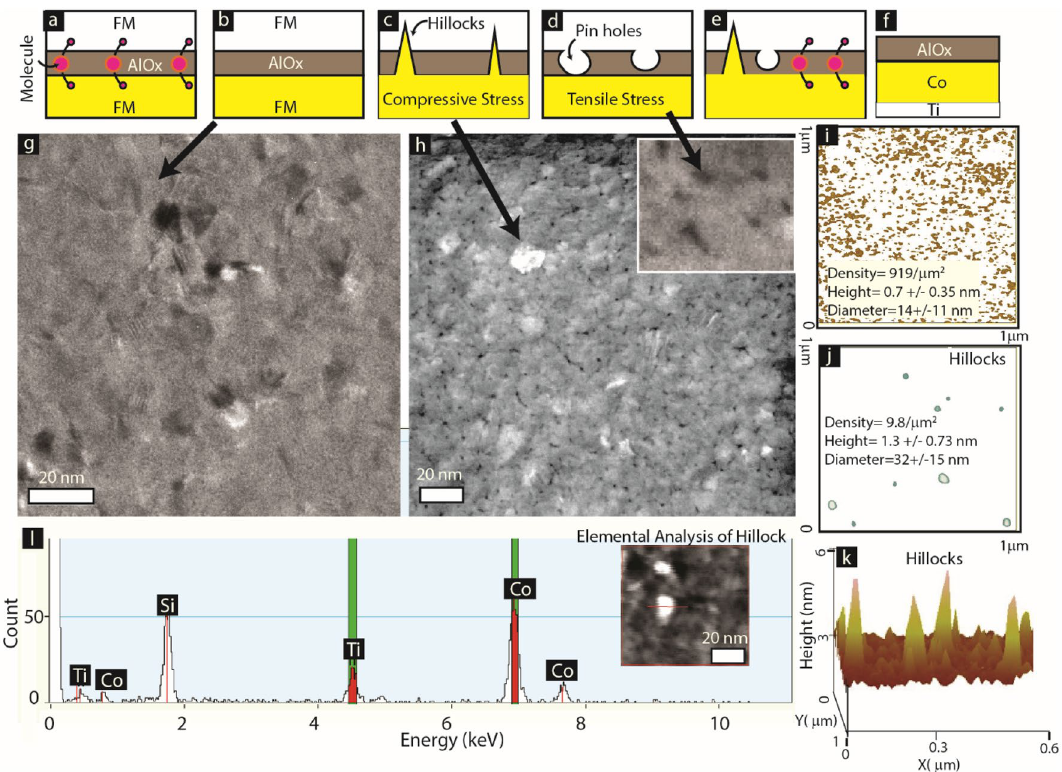
Figure 2. Conceptual sketches showing cross-sectional sideview of ( a ) an MTJMSD with defect free insulator, ( b ) MTJ testbed with defect free insulator, ( c ) MTJ with hillocks, ( d ) MTJ with pin holes, ( e ) an MTJMSD with competing molecule and defects. ( f ) Testbed used for investigating defects in AlOx. TEM image of ( g ) as produced and ( h ) thermally stressed Ti/Co/AlOx. Representative AFM image analysis quantify ( i ) pinholes, and ( j ) hillocks. ( l ) Compositional analysis confirming hillocks are made up of cobalt (Co) and Ti. Inset image in ( l ) correspond the site of compositional analysis in the TEM study. ( k ) 3D AFM image showing sharp hillocks. Panel ( a – e ) were sketched in Adobe Illustrator CS6. ( a – e ) Sketches, TEM images in panel ( g , h ), and and atomic force microscope images ( i ), ( j ), and ( k ) were assembled in Adobe Illustrator